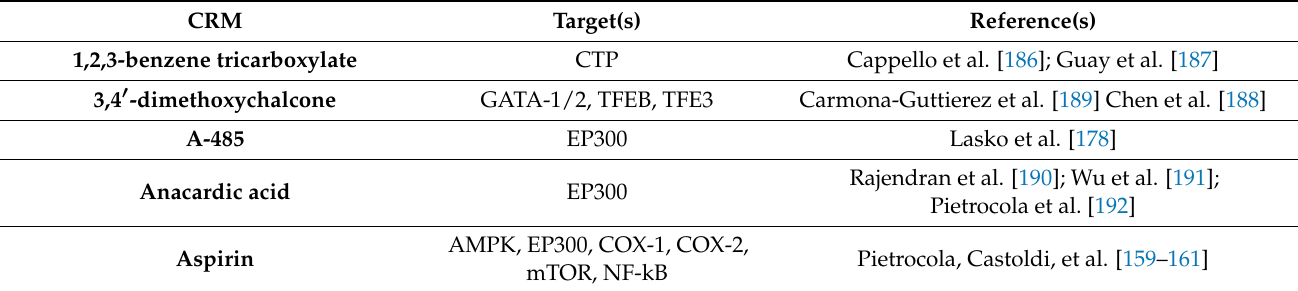
Table 1. Some non-toxic compounds inducing autophagy through protein deacetylation and referred to as CRMs. CRM